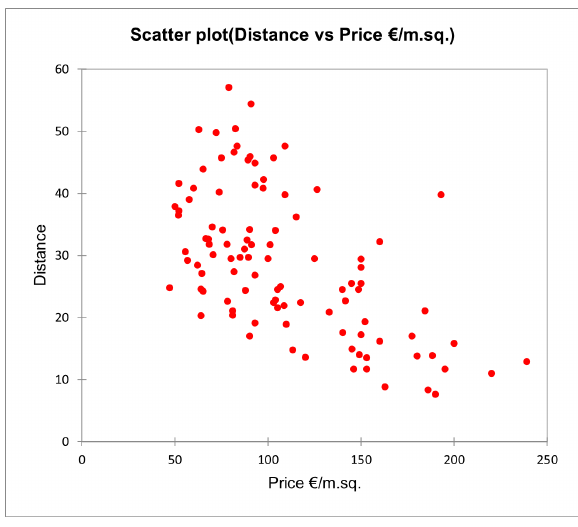
Figure 2: Scatterplot mapping distance vs price for land plots in Bratislava